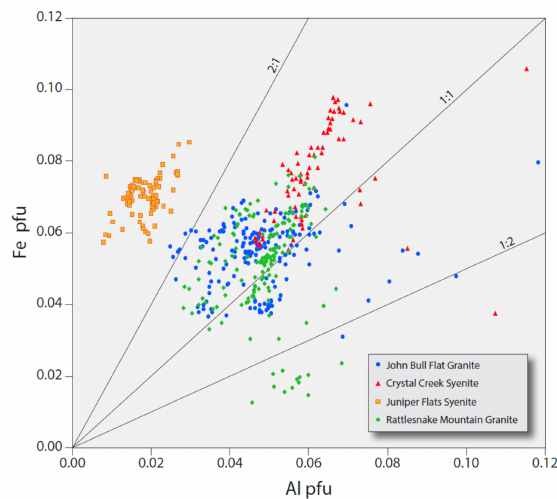
Figure 12. Fe versus Al in titanite from four Middle Jurassic plutons from the San Bernardino Mountains of southern California: John Bull Flat granite, Crystal Creek syenite, Rattlesnake Mountain granite, and the A-type Juniper Flats syenite. The high Al spots (Fe/Al < 1:1.5) are probably from hydrothermally precipitated titanite.